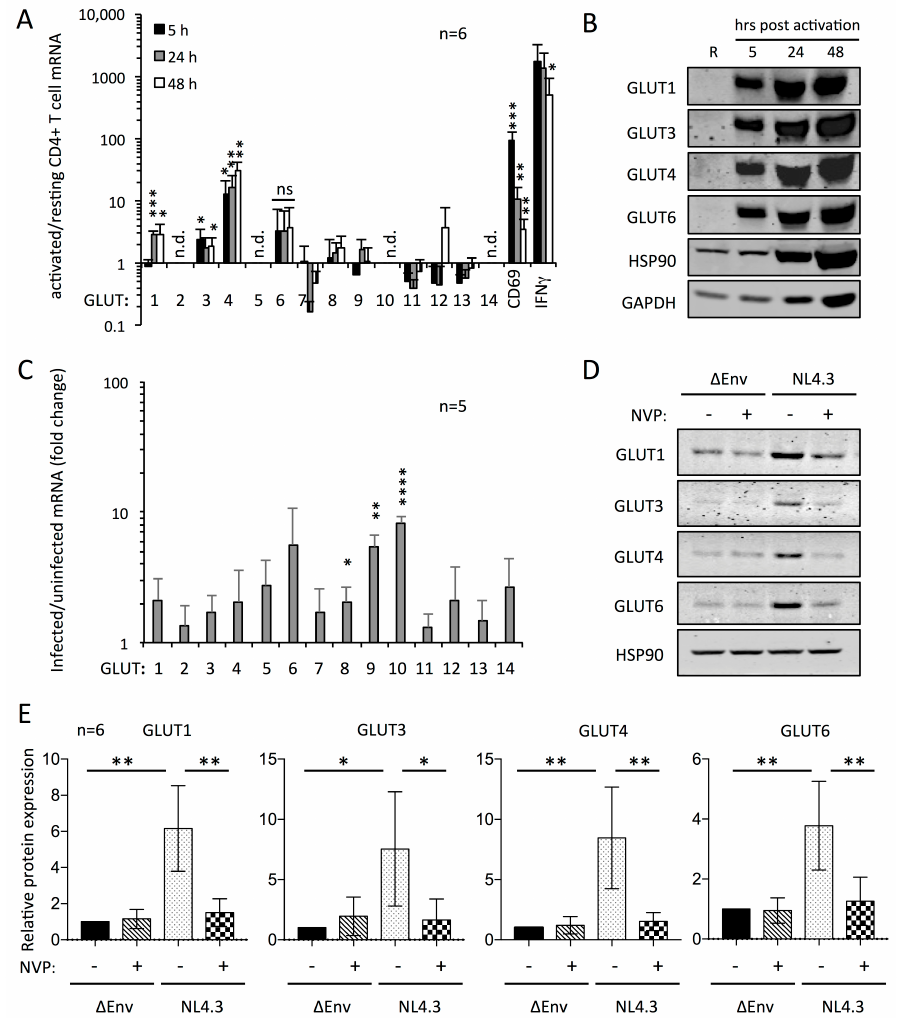
Figure 1. Multiple GLUT proteins are expressed in activated human CD4+ T cells and upregulated in response to infection with HIV-1. ( a ) The abundance of GLUT1-14, CD69, and IFN γ mRNA in activated relative to resting CD4+ T cells at 5, 24, and 48 h after activation from six donors as determined by qPCR: n.d. indicates not detected. The data are averages after normalization to three reference genes (18S, B2M, and EIF4A2), with error bars representing the standard deviation; ( b ) Representative Western blotting analysis showing the detection of GLUT proteins in equal numbers of resting (R) and activated human CD4+ T cells at 5, 24, and 48 h post stimulation with GLUT-specific antibodies. Blots for GAPDH and HSP90 are included as controls; ( c ) The relative abundance of GLUT1-14 mRNA in HIV-1 infected versus uninfected cells as determined by qPCR of samples from 5 donors; ( d ) Representative Western blotting analysis of the expression of GLUT1, 3, 4, and 6 of uninfected ( ∆ Env) and HIV-1 NL4.3 infected primary CD4+ T cells in the presence or absence of nevirapine (NVP). Equal numbers of infected and uninfected cells were used, and HSP90 is shown as the loading control; ( e ) Quantified data from Western blotting analysis shown in ( d ) from six different donors. Significance is indicated by * p ≤ 0.05, ** p ≤ 0.01, *** p ≤ 0.001, and **** p ≤ 0.0001. For qPCR data, significance is indicated for upregulated transcripts only, n.d. incicates not detected and ns indicated not statistically significant.